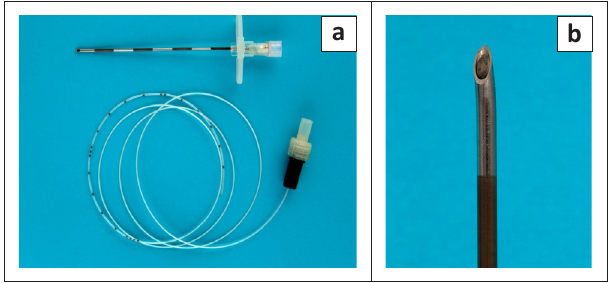
FIGURE 7: An (a) epidural needle and catheter (B-D® DurasafeTM 18G 405096; Becton Dickinson Benelux S.A., Erembodegem, Belgium), used for intravenous infusions and (b) the short bevel of the epidural needle.